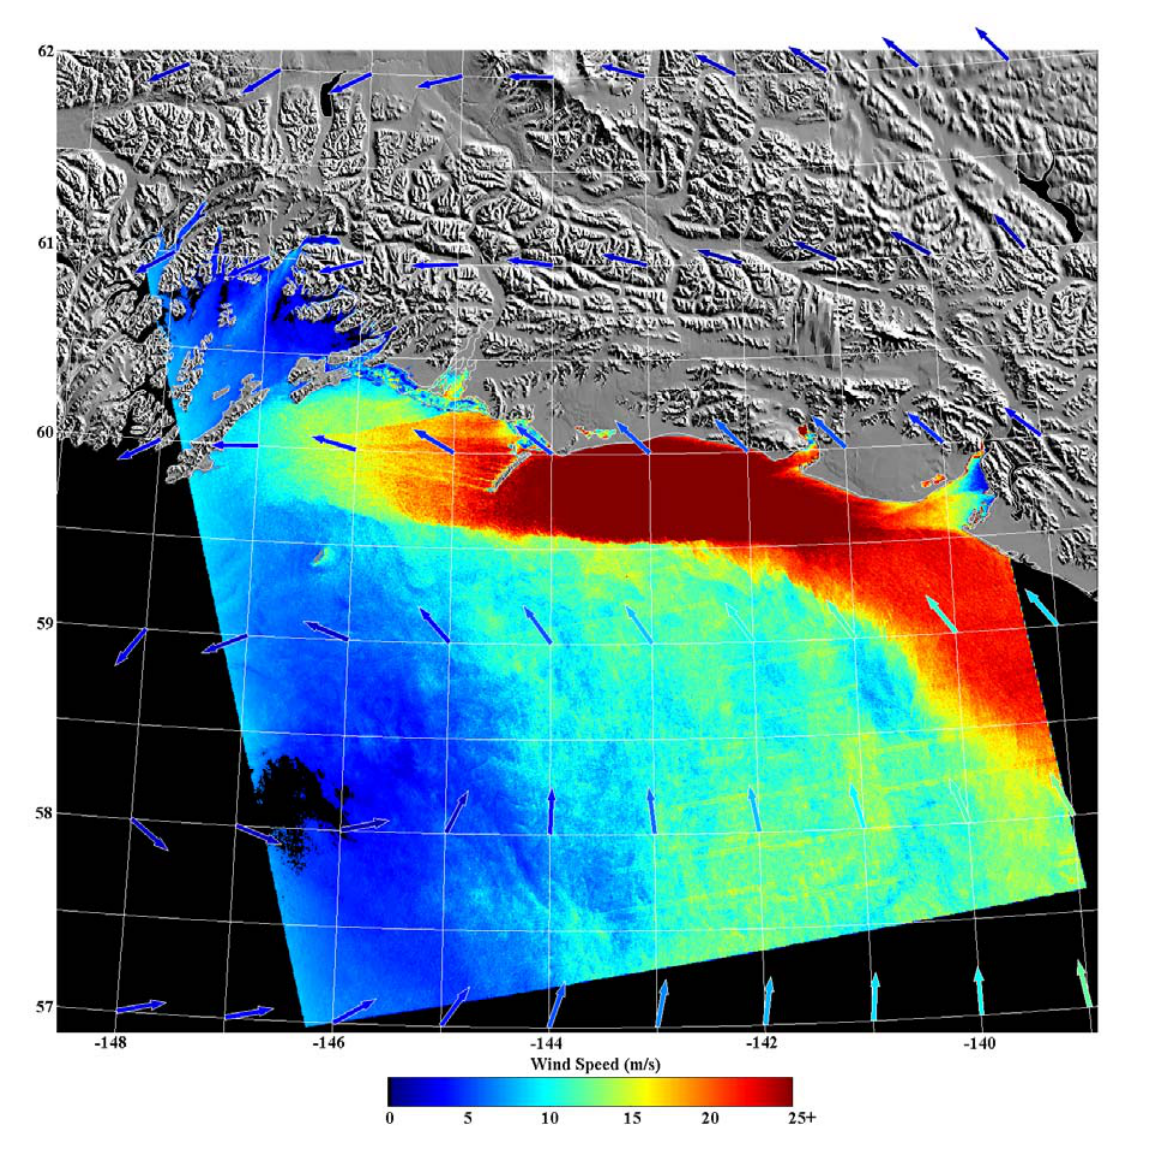
Figure 2. SDWS image from 0310 UTC on 18 February 2000